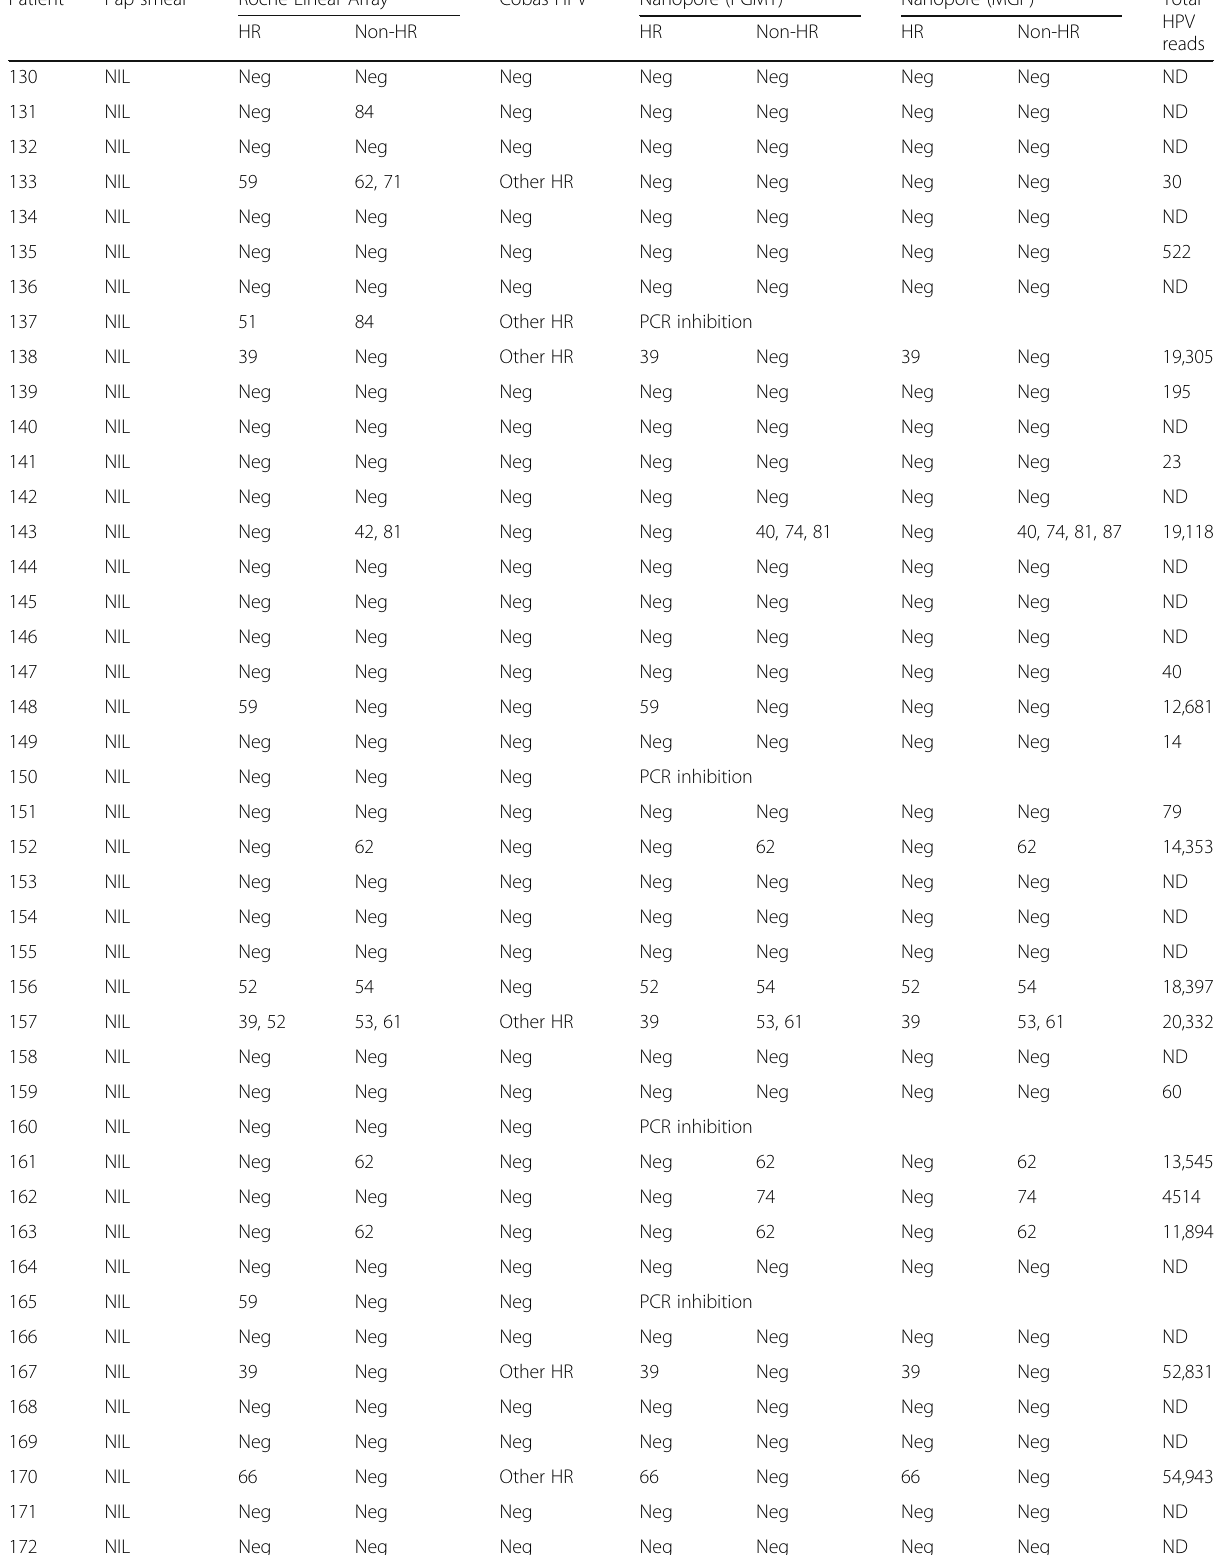
Table 1 Results of Pap smear, cobas HPV Test, Roche Linear Array HPV Genotyping Test, and Nanopore sequencing